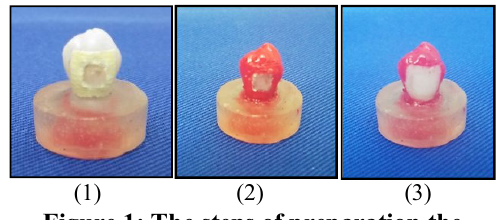
Figure 1: The steps of preparation